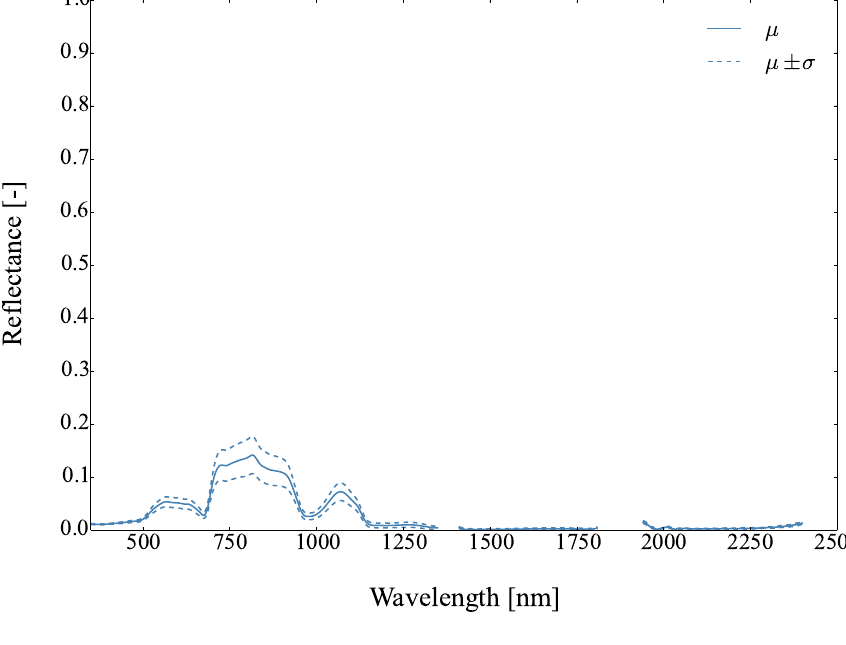
Figure A20. Mean reflectance ( µ ) and standard deviation ( σ ) of Aquatic type b